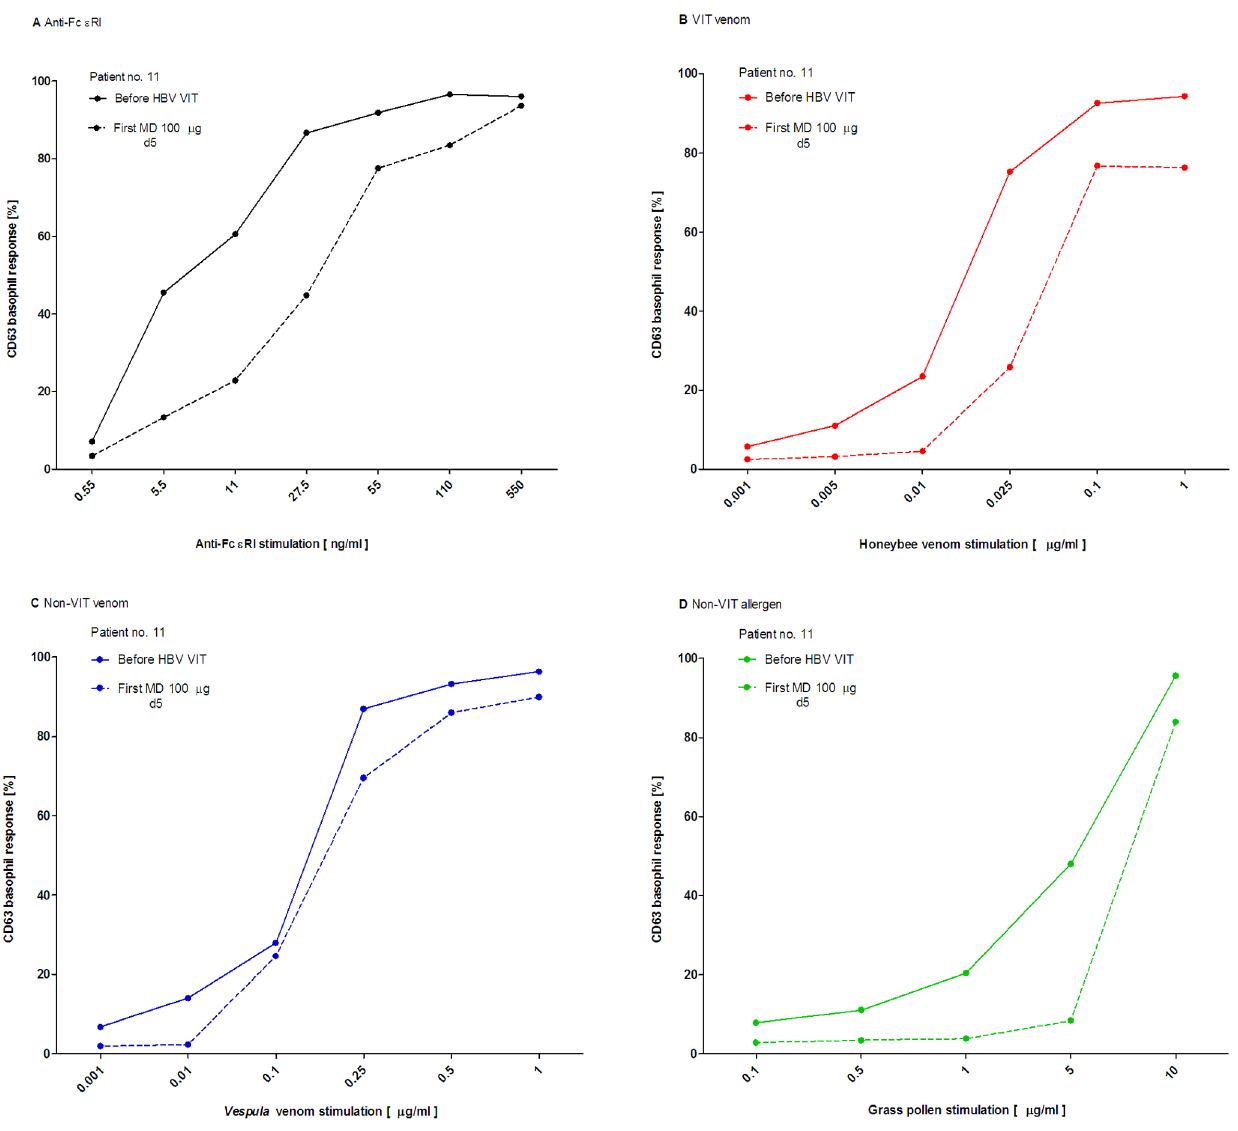
Figure 3. A–D. Basophil response in patient co-sensitized to grass pollen allergen. CD63 basophil dose-response curve in poly-sensitized patient no. 11 in A to anti-Fc e RI in B to honeybee in C to Vespula venom and in D to grass pollen stimulation before treatment and the